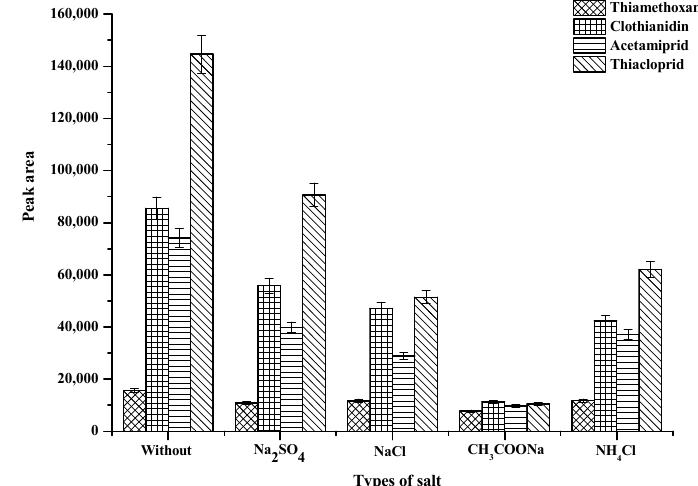
Figure 4. Effect of types of salt. Conditions: 400 µL of ACN; 100 µL of 0.1-mol·L − 1 SDS; vortex time 60 s; 100 µL of hydrophobic DES (mole ratio 3:1); centrifugation time at 5000 rpm for 10 min (sample volume 10 mL, 0.5 µg·mL − 1 of each neonicotinoid insecticide).